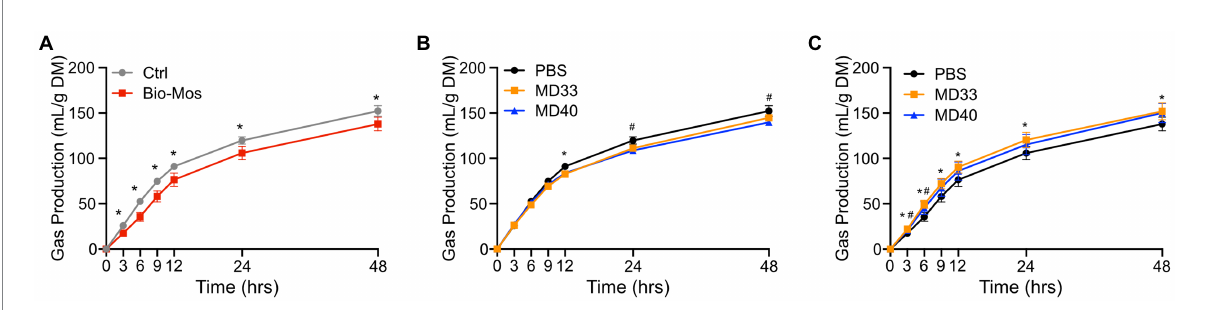
FIGURE 4 Gas production of ex vivo rumen systems. (A) Comparing control treatments (PBS added, no probiotic) of Control and Bio-Mos® supplemented diets. * p < 0.05. Comparing differences of high probiotic dose inoculation of MD33 and MD40 strains supplemented with (B) Control or (C) Bio- Mos®. * p < 0.05 between control and MD33 treatments. # p < 0.05 between control and MD40 treatments. N = 4. Rumen samples collected from cannulas of cattle fed control or Bio-Mos® supplemented diets.